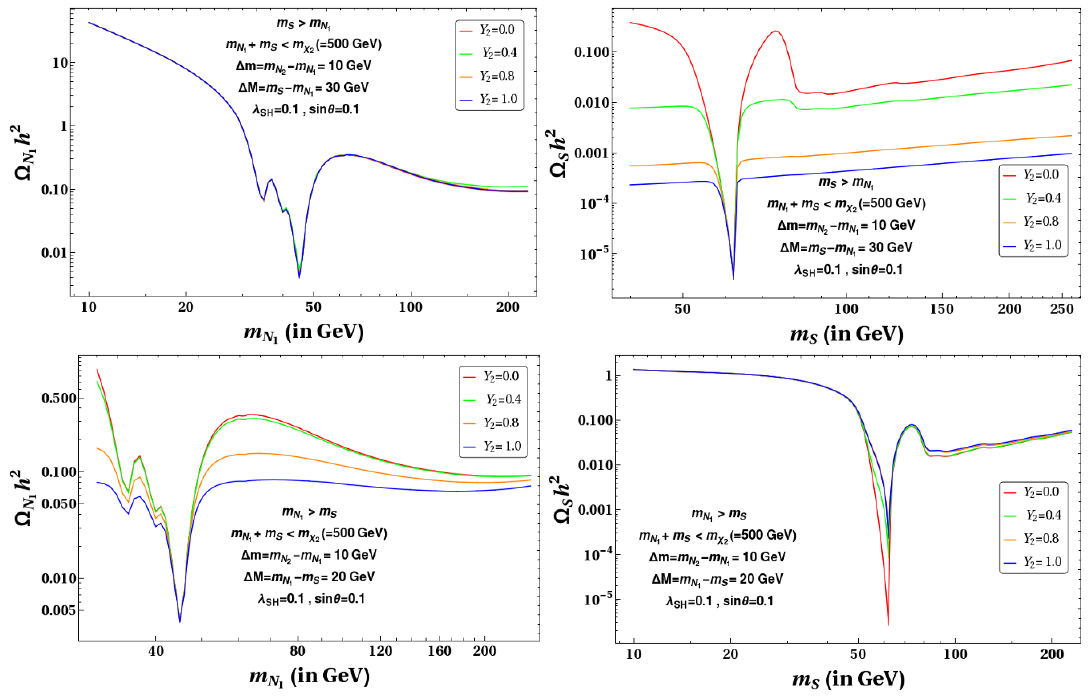
Figure 7 . Relic densities ((cid:10) N h 2 and (cid:10) S h 2 ) of the individual DM components as a function of 1 respective DM masses ( m N and m s ) shown in left and right panel respectively. Two possible mass 1 hierarchies are shown: m S > m N (top panel) and m N > m S (bottom panel). Di(cid:11)erent values of 1 1 Y 2 = 0 : 0 (red) ; 0 : 4 (green) ; 0 : 8 (orange) ; 1 : 0 (blue) are chosen keeping other parameters (cid:12)xed (as mentioned in the plots) to decipher DM-DM